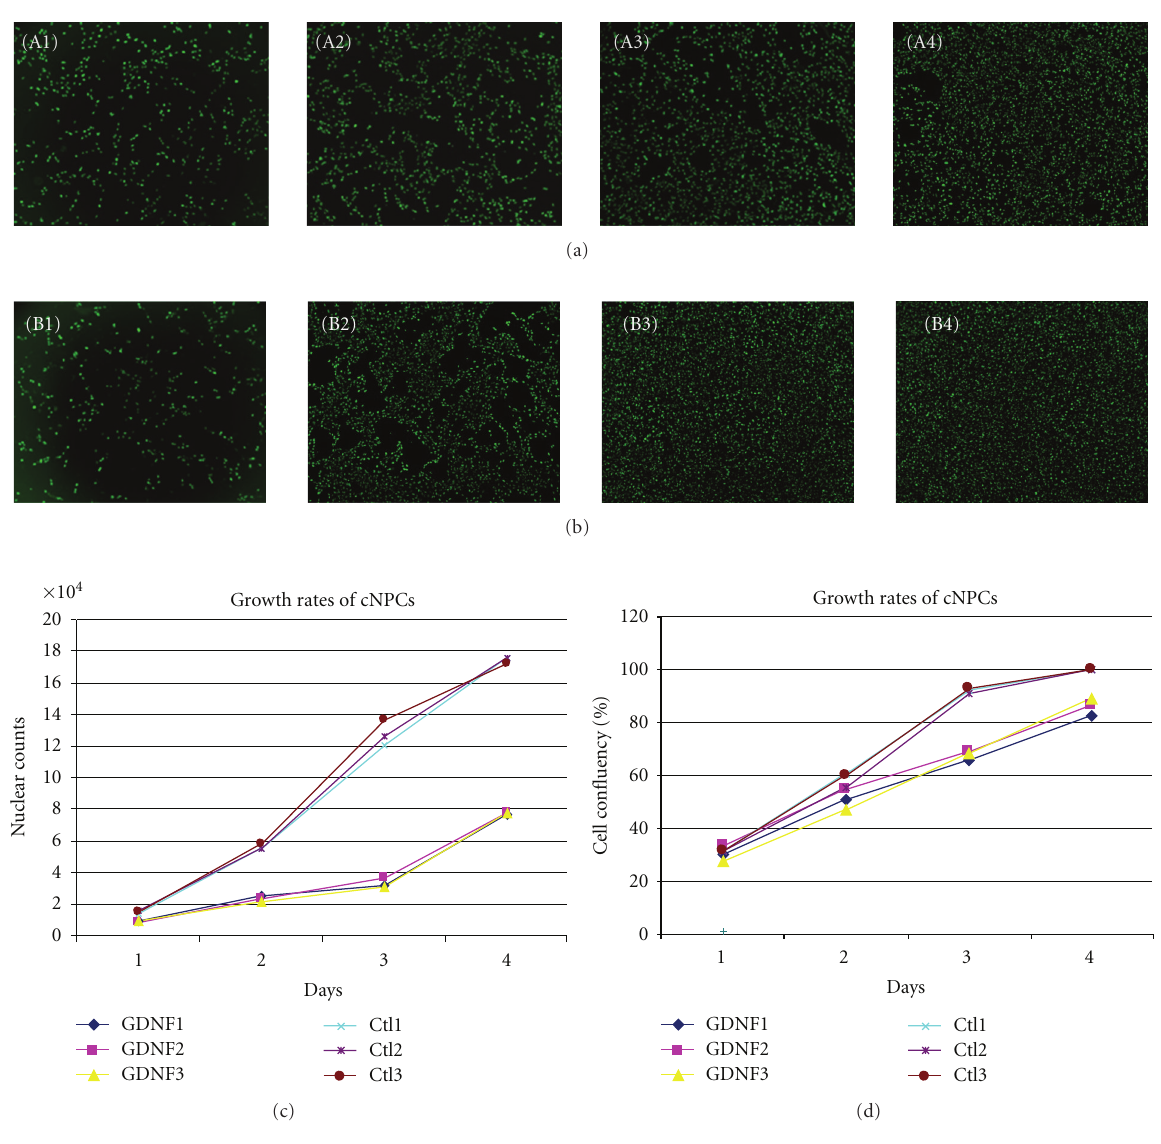
Figure 3: Growth of nontransfected and pCAG-PyF101-eGDNF plasmid transfected cNPCs. The fluorescence stained nuclei of (a) transfected and (b) nontransfected cNPCs. cNPCs were cultured in 24-well plate in UM for 4 days. Cells were labeled with a marker for nuclear DNA, and an IncuCyte live cell monitoring system was used to assess the growth rate of cells on each day. (a) GDNF-transfected cNPCs; A1–4: Day1–4. (b) Nontransfected cNPCs; B1–4: Day1–4. (c, d) Growth curves of GDNF-transfected and nontransfected cNPCs (labeled GDNF and Ctl, resp.) imaged and analyzed using an IncuCyte live cell monitoring system. Cells were stained with Vybrant Dycycle fluorescence nuclear-specific dye daily for 4 consecutive days (c). At the same time, cells in duplicate sets of wells without nuclear stain were measured for percentage cell confluency (d). The tight grouping of control data in (d) makes it di ffi cult to discern Ctl1, which is present in the upper group and reaches confluence rapidly along with the other nontransfected cNPCs. IncuCyte programs were used for both analyses (c,